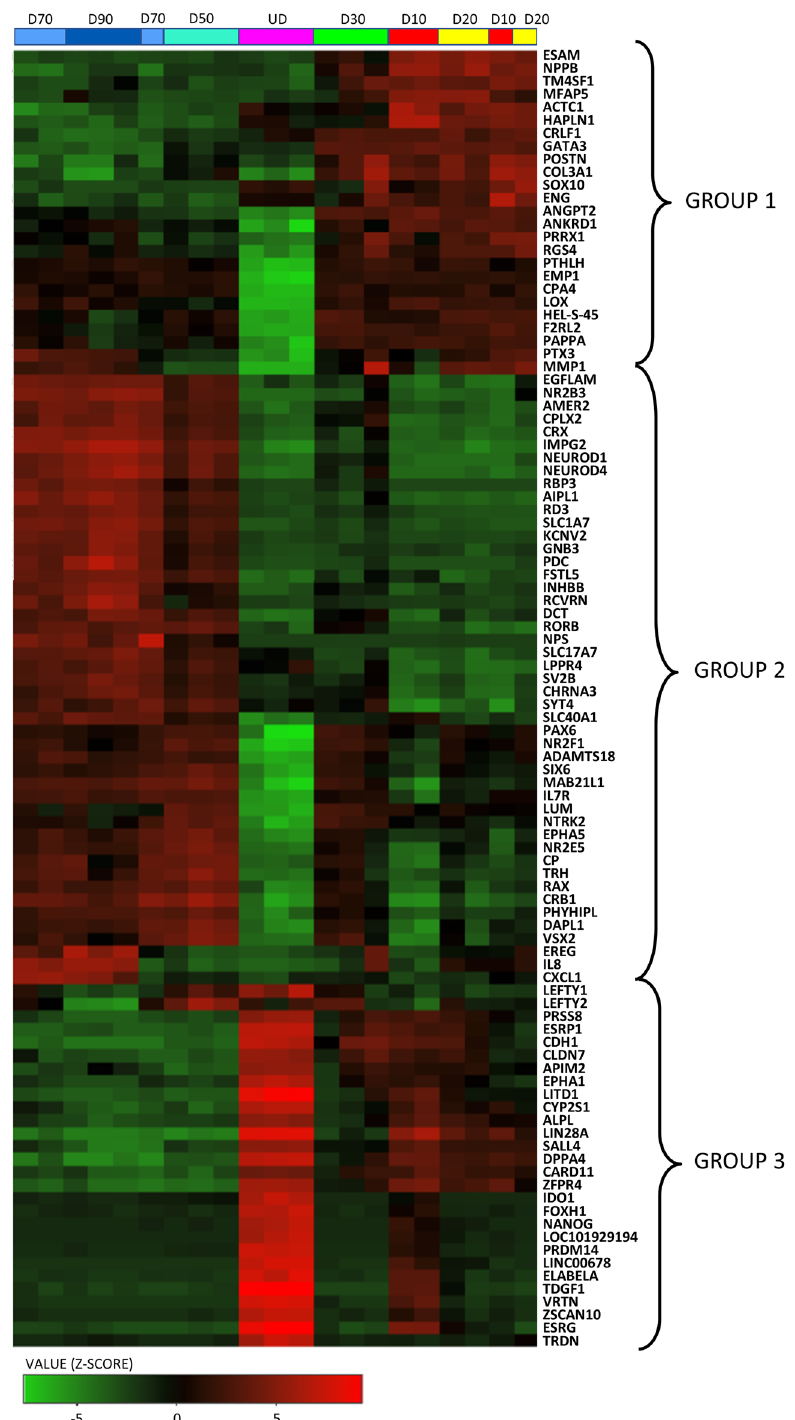
Figure 3. Heatmap of the top 50 variable genes. Heatmap shows the top 50 most variable genes amongst all sample replicates. All genes were ranked by standard deviation across all samples, then used in hierarchical clustering using the heatmap.2 function in iDEP91. Colour key indicates z-score (green = negative; black = no change; red = positively